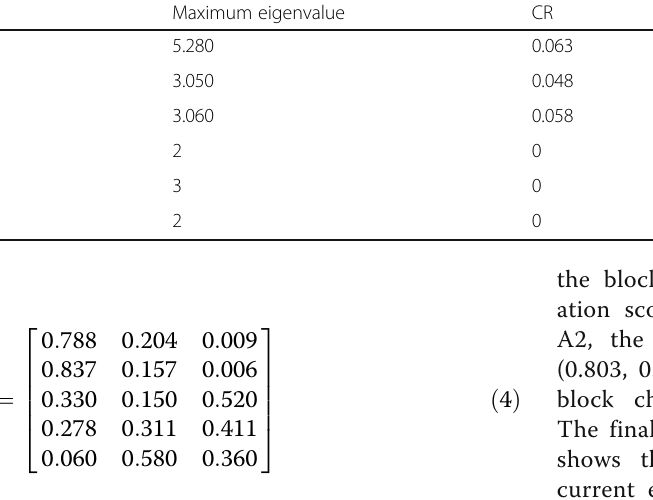
Table 3 Matrix calculation result Matrix